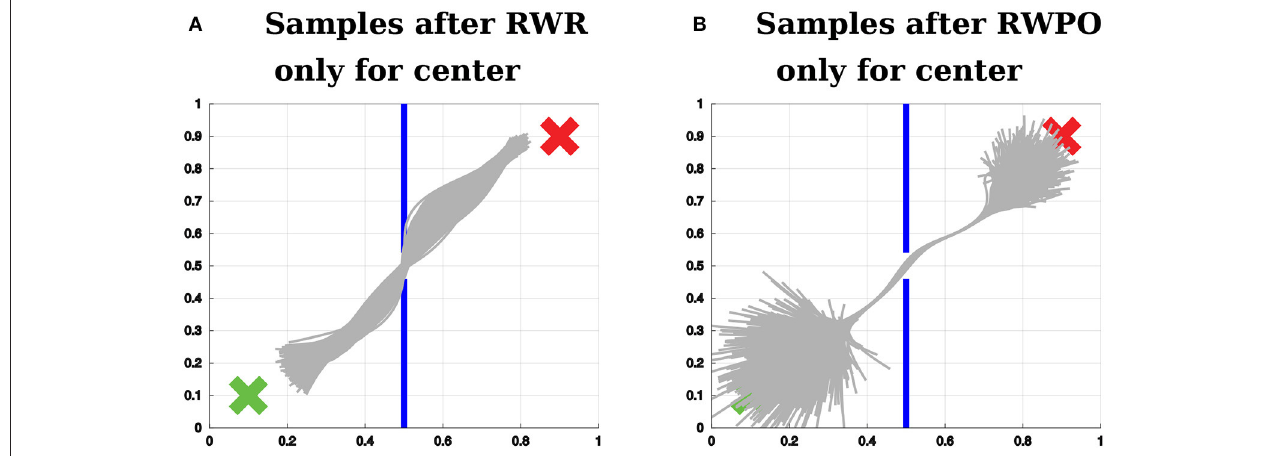
FIGURE 10 | (A) Sample trajectories after using Reward-weighted Regression (RWR) to optimize the distribution over trajectories with respect to passing through the center of the window. (B) Sample trajectories after using Relevance Weighted Policy Optimization (RWPO) to optimize the distribution over trajectories with respect to the same objective, using the same reward function. In contrast to RWR, RWPO finds a better policy to avoid hitting the wall and does not shrink the variance of parts of the trajectories that are far away from the region of interest.